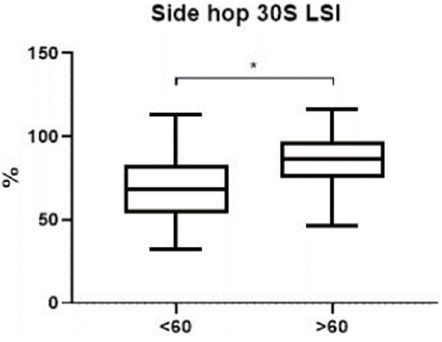
Figure 8. Box-plot showing differences in Side Hop test LSI between the two groups. The Figure 8. Box ‐ plot showing differences in Side Hop test LSI between the two groups. The black line inside the box represents median value. The lowest bar represents the minimum value, the bottom and top of the box represent the interquartile range (25th and 75th percentiles), and the top bar represents the maximum value. * p < 0.05. 4. Discussion The most important finding of the present study was that patients with higher values of ACL ‐ RSI scores showed better functional clinical outcomes according to Lysholm and Tegner scores as well as improved performance as measured with side ‐ hop test six months after ACL reconstruction. According to our results, six months after surgery, subjective knee function accord ‐ ing to point ‐ scales significantly improved compared to pre ‐ operatory status, thus sup ‐ porting the efficacy of hamstring ACL reconstruction in athletes. Functional tests are commonly used to assess the return ‐ to ‐ sport ability following ACL reconstruction. In our cohort of patients, a test battery of vertical jumps measured with an optical acquisition equipment was adopted to evaluate jump performance follow ‐ ing ACL surgery. Assessment of vertical jump to detect function deficits of the lower limb with ACL injury or following ACL surgery has been previously reported [11,12,24]. The battery of vertical jump tests used in the present investigation involved bipodalic SJ, bipo ‐ dalic and monopodalic CMJs, and 30 s side hop test. Such tests, by measuring jump height as an expression of knee explosiveness, coordination, and dynamic knee stability, are re ‐ liable predictors for the return to sport after ACL surgery. Based on the results of these test batteries, LSI was calculated to evaluate knee status and patient ability to return to cutting and pivoting sports. Six months after surgery, the ability to perform bipodalic CMJ, monopodalic CMJ on the injured limb, and a 30 s Side Hop test on the injured limb significantly improved at follow ‐ up compared to pre ‐ operatory status. Similarly, an improvement in LSI recorded while performing CMJ and Side Hop test LSI was observed. Previous studies investigated the relationship between psychological readiness and functional performance [13,25,26]. The ACL ‐ RSI score demonstrated to be a reliable scor ‐ ing scale while evaluating psychological readiness for return to sports after ACL recon ‐ struction [17,18]. In the study by McPherson et al., patients who underwent ACL re ‐ rup ‐ ture trended toward lower ACL ‐ RSI scores [19], while according to Sadeqi et al., ACL ‐ RSI score ≥ 60 months after surgery is a reliable predictor of return to preinjury sport [27]. According to the study by Aizawa et al., in our case series, we considered 60 as a cut ‐ off value to evaluate psychologic readiness to return to sport six months after surgery [13]. Webster et al. followed up with 635 athletes 12 months after ACL reconstruction, and ob ‐ served that greater limb symmetry while performing a single ‐ legged hop for distance pos ‐ itively correlates with the ACL ‐ RSI score [26]. Similarly, in the study by Aizawa et al. on athletes aiming to return to sport participation six months after surgery, LSI while per ‐ forming jump tests affected the ACL ‐ RSI score [25].